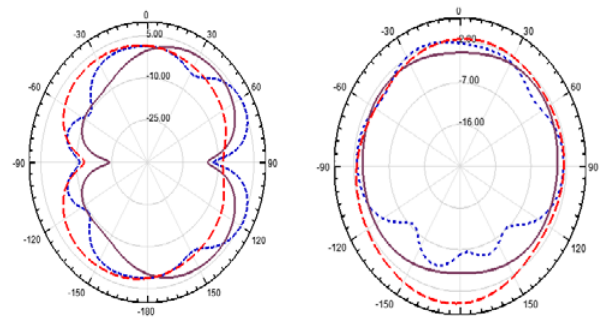
Figure 6: S 11 characteristics of the proposed antenna for different capacitance values in position one